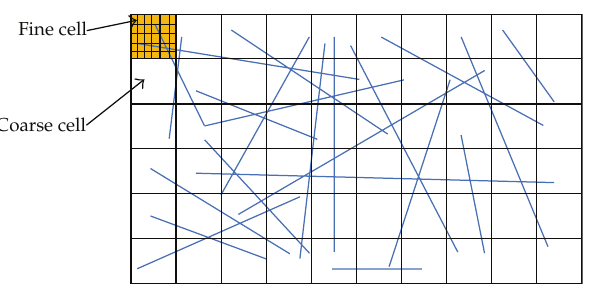
Figure 1: Representative coarse and fine